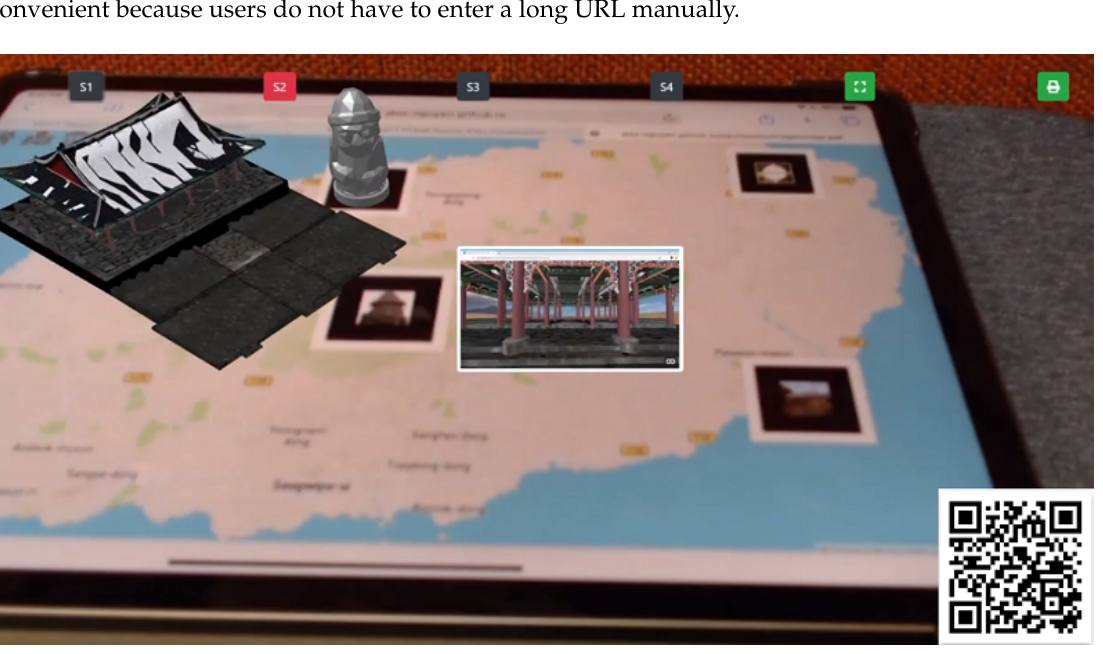
Figure 5. The main interface of the AR